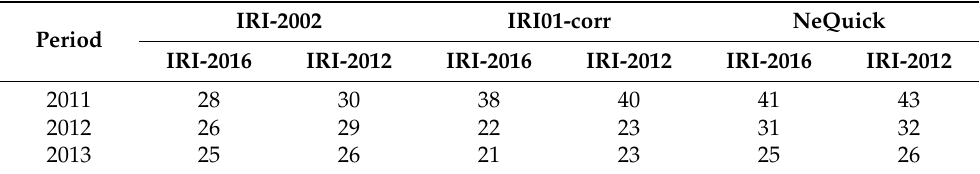
Table 2. The maximum DVTEC values in IRI-2001, IRI01-corr, and NeQuick for IRI-2016 and IRI-2012 models during disturbed